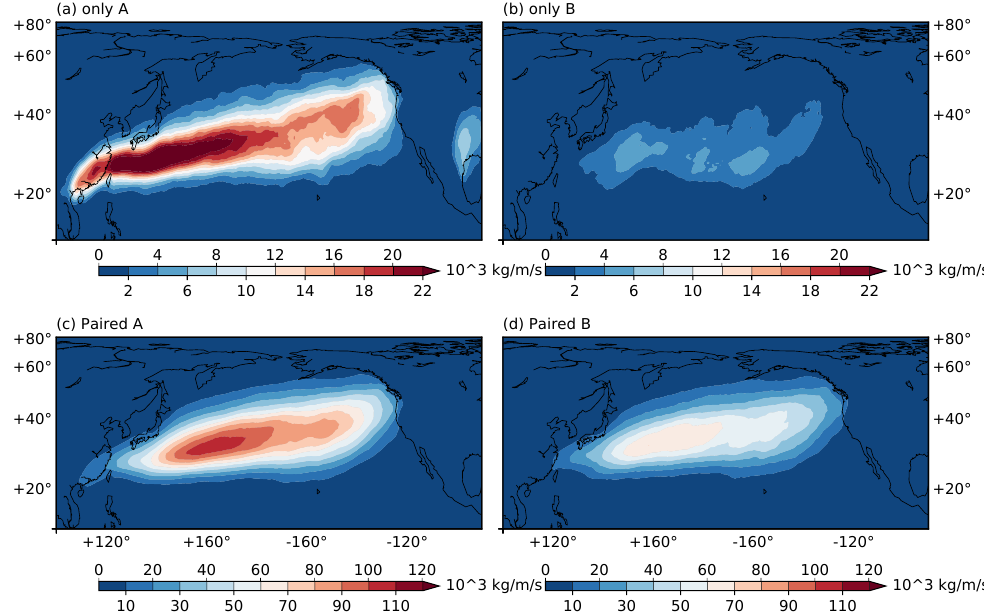
Figure 7. Average seasonal IVT accumulations (in 10 3 kg/m/s) attributed to ( a ) ARs detected only by the method THR (labelled “A” for short, corresponds to the Only A category in Table 1a). ( b ) ARs detected only by the method IVT250ano (labelled “B” for short, corresponds to the Only B category in Table 1a). ( c ) ARs detected by method A when it is paired with an AR detected by method B (Paired A category in Table 1a). ( d ) ARs detected by method B when it is paired with an AR detected by method A (Paired B category in Table 1a). Note that the bottom panel uses a different